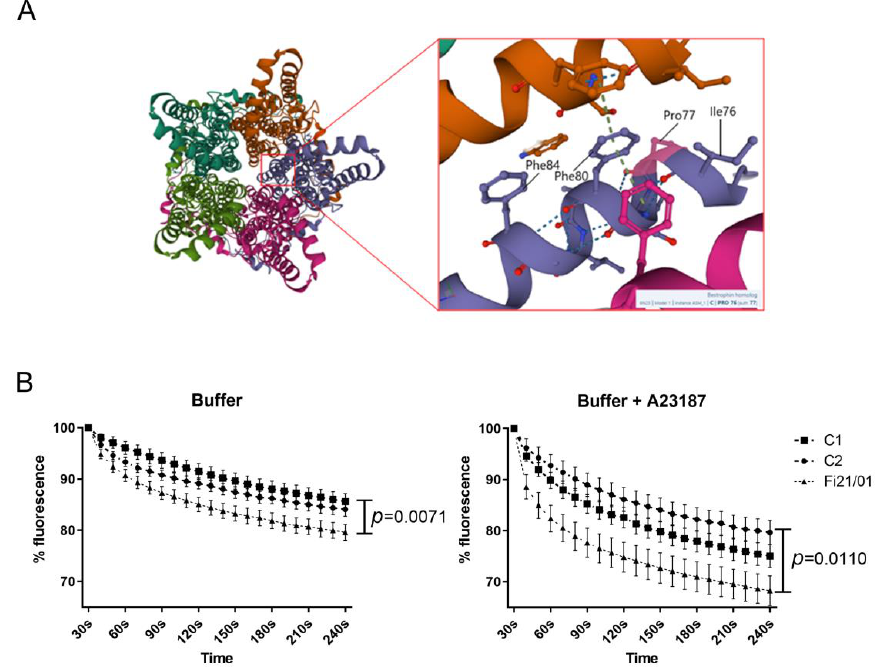
Figure 5. BEST1 structure and halide permeability in iPSC-RPE cells. ( A ) BEST1 channel pentameric structure in a calcium-free closed state (ProteinDB: 6N26) showing the neck residues Phe84, Phe80, and Ile76 critical for neck opening and closure and Pro77, which is mutated in the Fi21/01 patient. ( B ) Percentage of fluorescence from the Premo Halide Sensor shown from 30 s until 240 s (normalized at 100%). Buffer or buffer + A23187 were added at 20 s after the start of the recording. All experiments were performed with 17 – 21 replicates in three independent experiments with both controls and Fi21/01 iPSC-RPE cells. Significance was determined by Two-way ANOVA with Bonferroni comparison test.